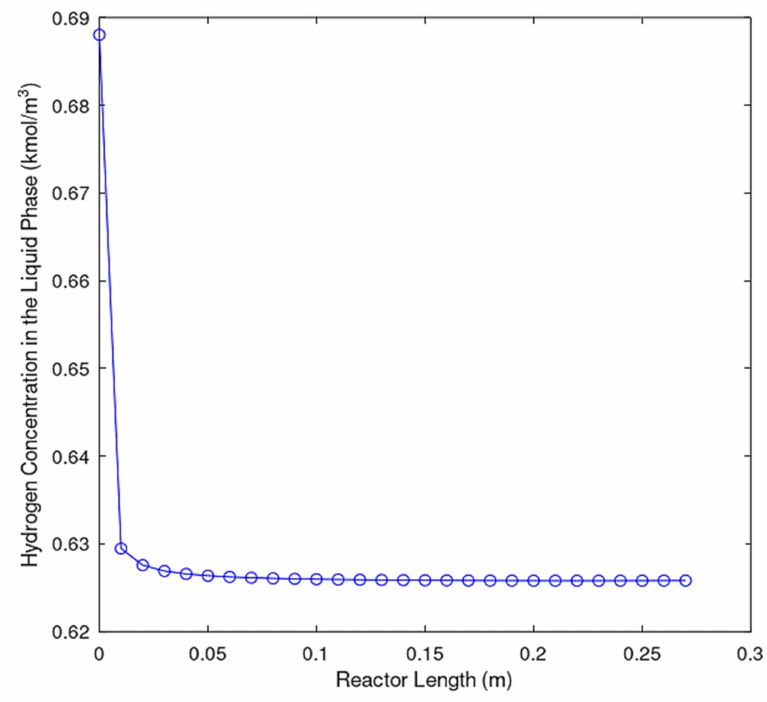
Figure 8. Hydrogen concentration in the liquid phase.